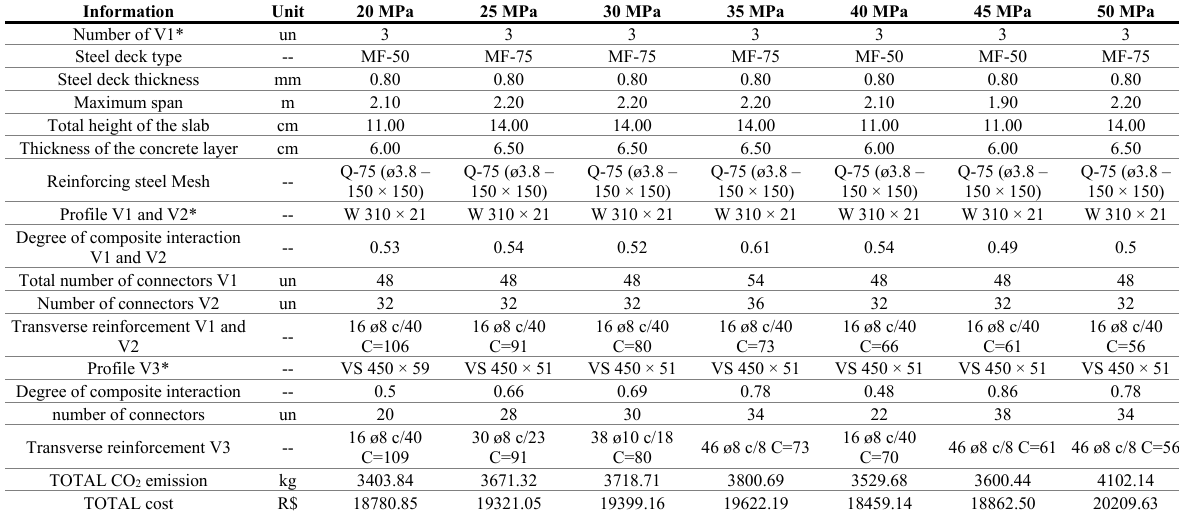
Table 6. Results from example 1 for different values of f